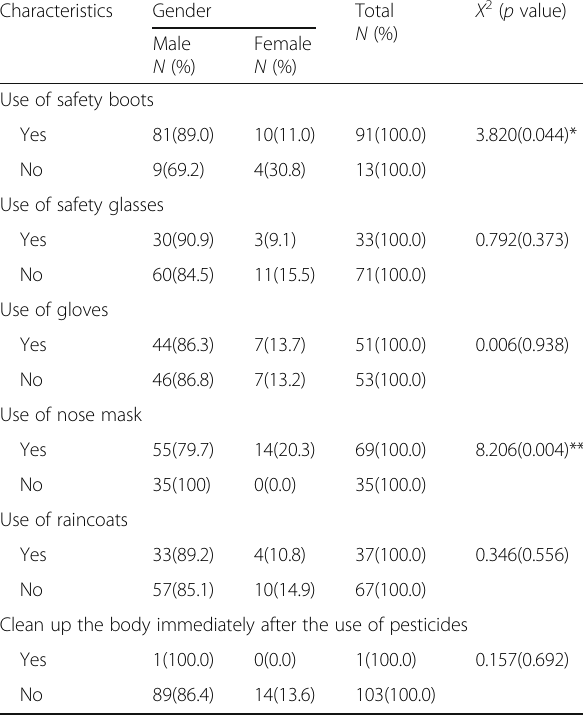
Table 5 The correlation between participants ’ gender and the practice of OHS ( N =